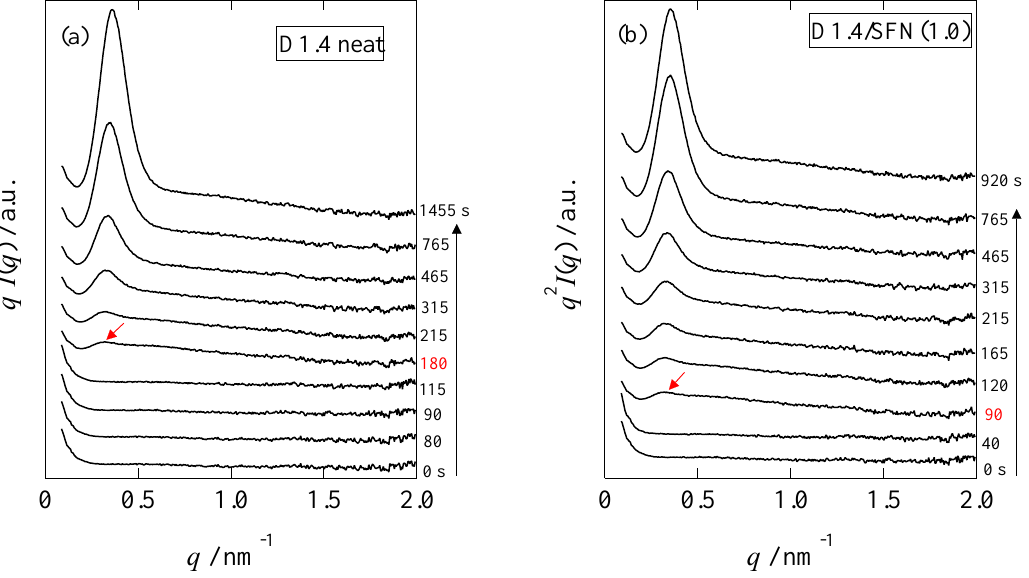
Figure 8. Changes in the Lorentz-corrected SAXS profiles as a function of time for ( a ) D1.4 neat and ( b ) D1.4/SFN(1.0) specimens during the isothermal crystallization at 110 °C from melt. The red arrow indicates the first detection of the peak.